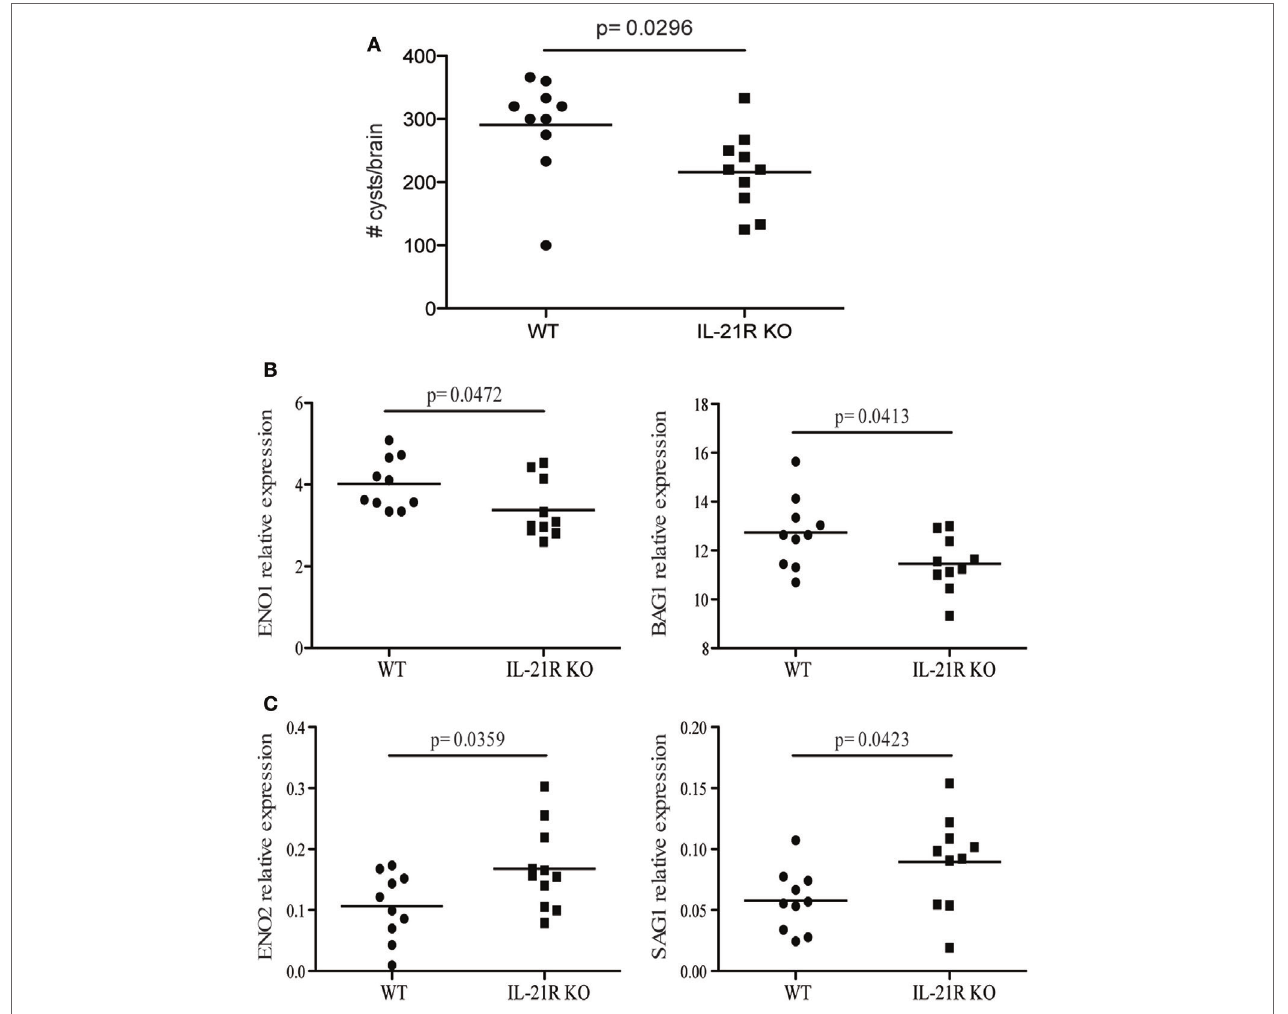
FigUre 4 | IL-21 is critical for the regulation of Toxoplasma gondii reactivation. Cyst numbers were evaluated in the brain of WT and IL-21R knockout (KO) mice at 7 weeks p.i. (a) . Relative mRNA expression of tachyzoites ( SAG1 and ENO2 ) (c) and bradyzoites ( BAG1 and ENO1 ) (B) specific genes in the brain of WT and IL-21R KO mice at 7 weeks p.i. Expression of abovementioned genes was relative to T. gondii -specific β actin. Experiments were carried out at three times and data are representative of three combined